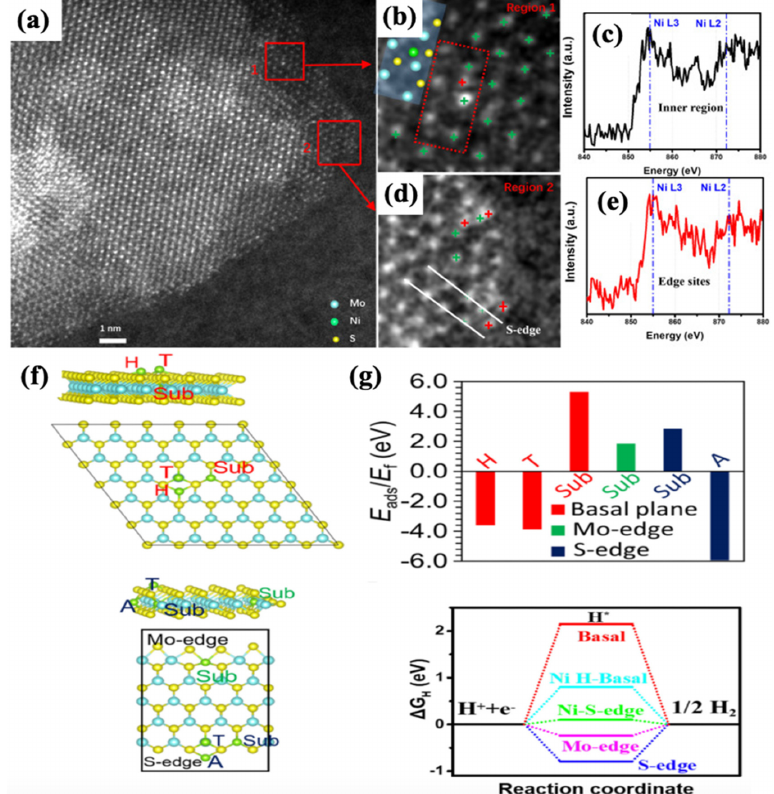
Figure 13. ( a ) STEM images of NiSA-MoS 2 /CC and the magnified images of ( b ) region 1 and ( d ) region 2; Ni atoms are represented by red crosses and Mo atoms are represented by green crosses. EELS spectra of Ni for ( c ) inner region 1 and ( e ) edge sites at region 2. ( f ) Atomic-level configuration of the absorption of Ni on the basal plane for both the top of the Mo sites (T) and the center of the hexagon sites (H); Mo atom substitution in the MoS 2 monolayer with Ni and the configuration of Ni absorption on the S-edge at T and A sites; and Mo atom substitution at the Mo-edge and S-edge with Ni. ( g ) Ni adsorption energy on MoS 2 and Mo atom substitution energy in MoS 2 , as well as H* adsorbed Gibbs free energies at the basal plane, the Mo edge and the S edge either with or without Ni adsorption/substitution. Reproduced from Elsevier [81]. Scanning transmission electron microscopy (STEM) demonstrates that the Ni single atoms were attached to the basal plane’s S-edge and H sites. The corresponding electron energy loss spectroscopy (EELS) spectra of these sites identify the appearance of Ni peaks at 855 eV, indicating that the embedded atoms are Ni atoms (Figure 13d). According to